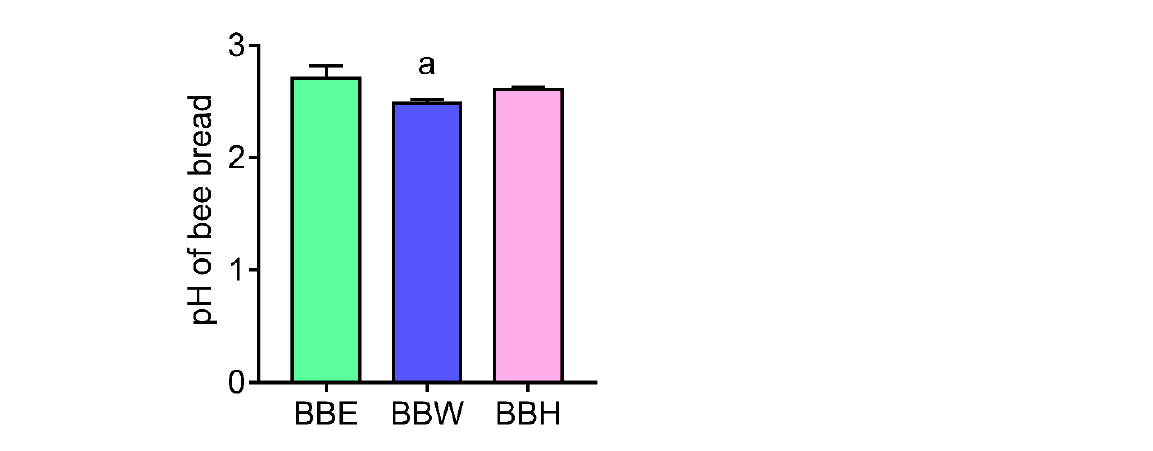
Figure 1. pH of bee bread. BBE: bee bread ethanol extract, BBW: bee bread water extract. BBH: bee bread hot water extract, a p < 0.05 versus BBE.